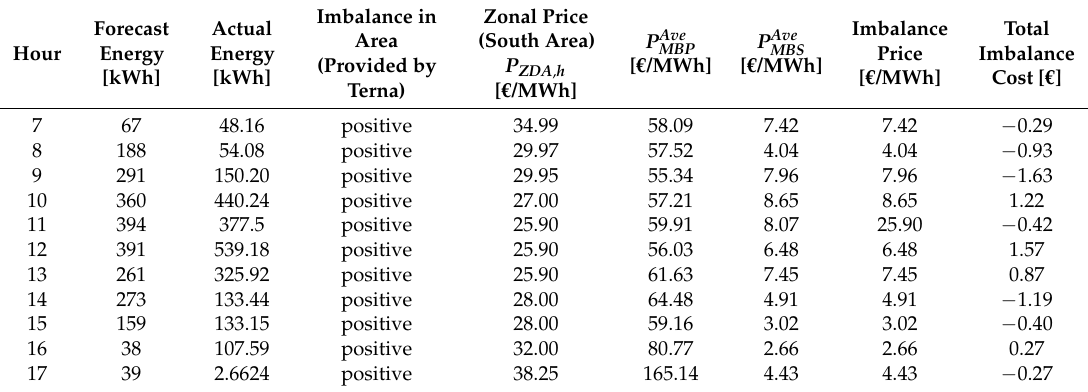
Table 3. Example of imbalance data and payments for a typical March